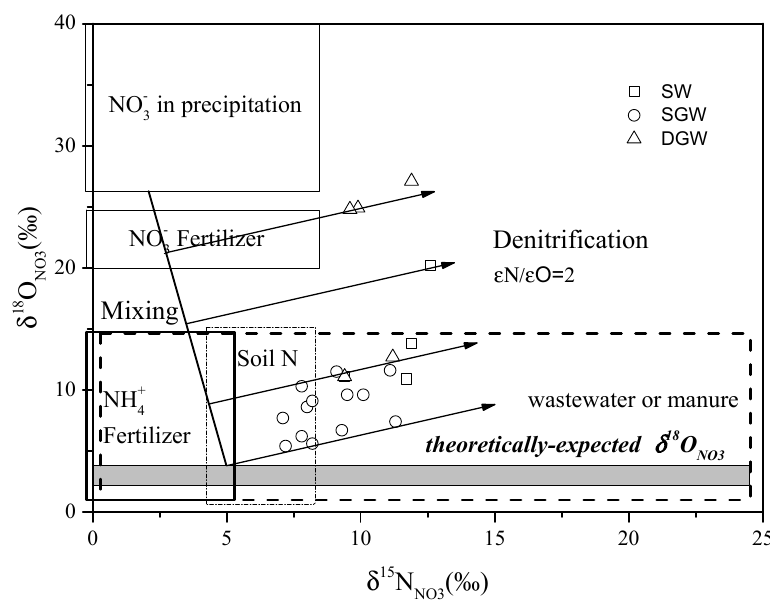
Figure 8. Isotopic values of surface water and groundwater dissolved NO (cid:2871)(cid:2879) plotted with the ranges of the potential NO (cid:2871)(cid:2879) sources in the study area [4,9,48]. (SW: Surface water; SGW: Shallow groundwater; DGW: Deep groundwater).